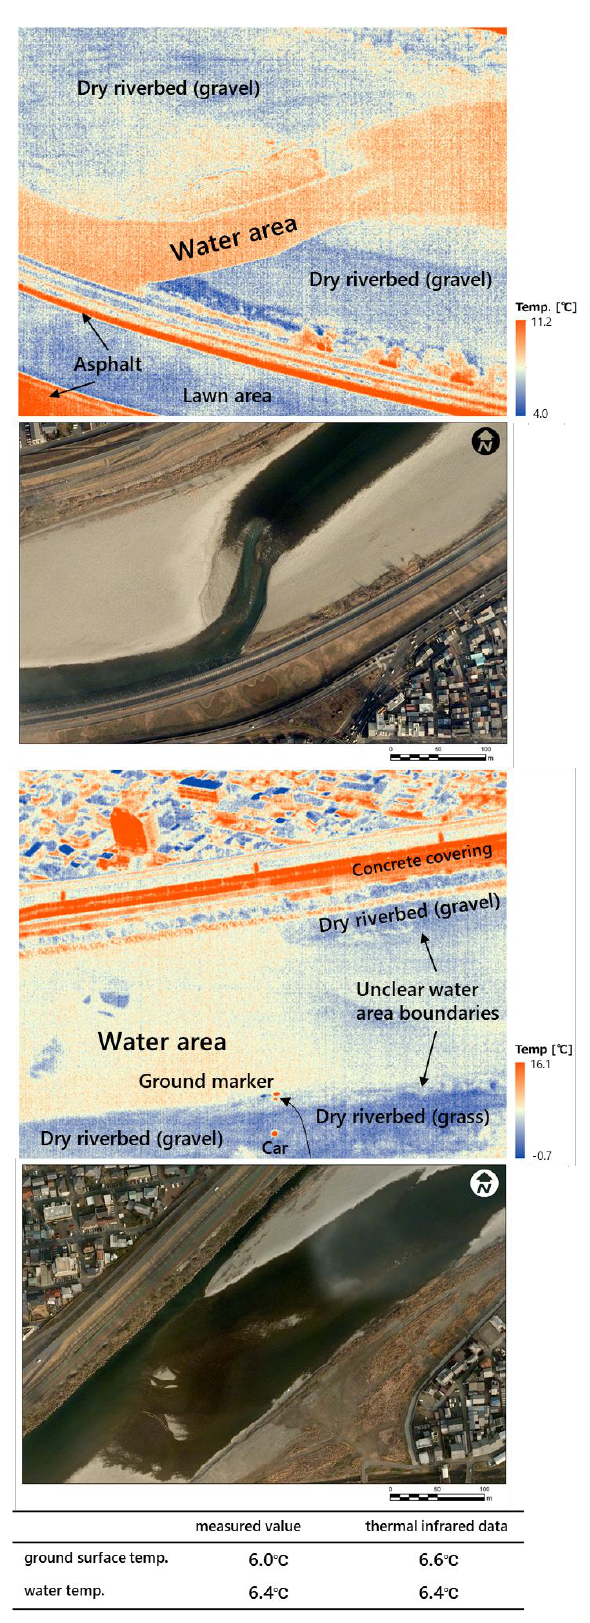
Figure 5. Thermal infrared camera images captured with the telephoto lens. The images below each temperature images are an ortho image containing the same location as the temperature